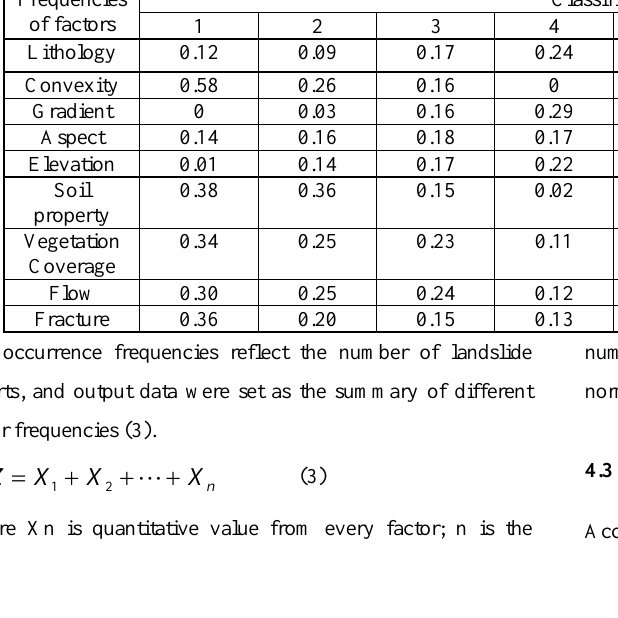
Classification Frequencies